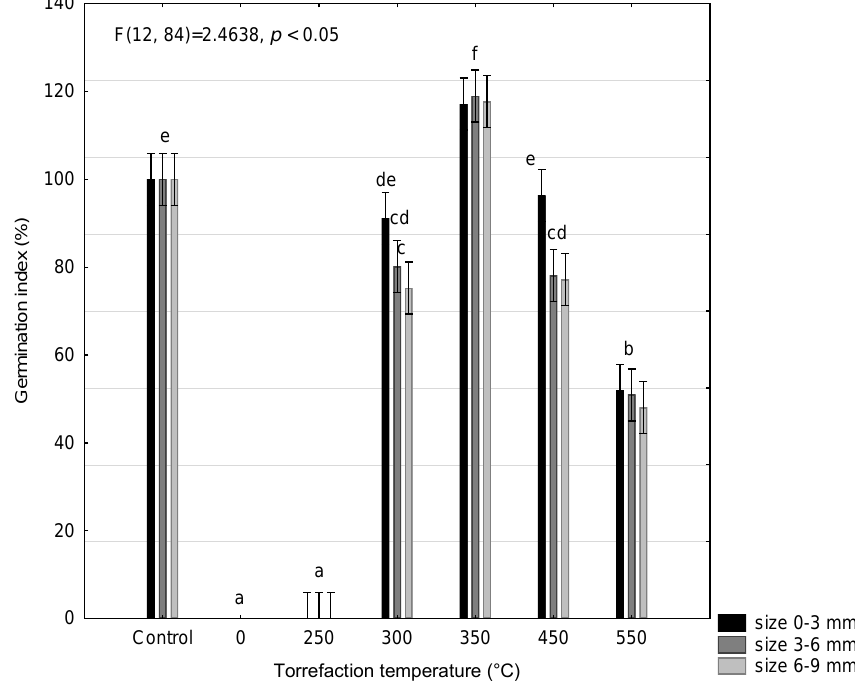
Figure 10. Phytotoxicity affects different grinding fraction sizes of tea aqueous extracts on the ger- mination of Lepidium sativum L. seeds after 48 h. Data are expressed as means of five independent bioassays (five replicates for each concentration (aqueous extracts) per bioassay) ± SE. The different letters (a – e) indicate significant differences between treatment effects when compared to the control (ANOVA, Tukey’s test, p < 0.05).